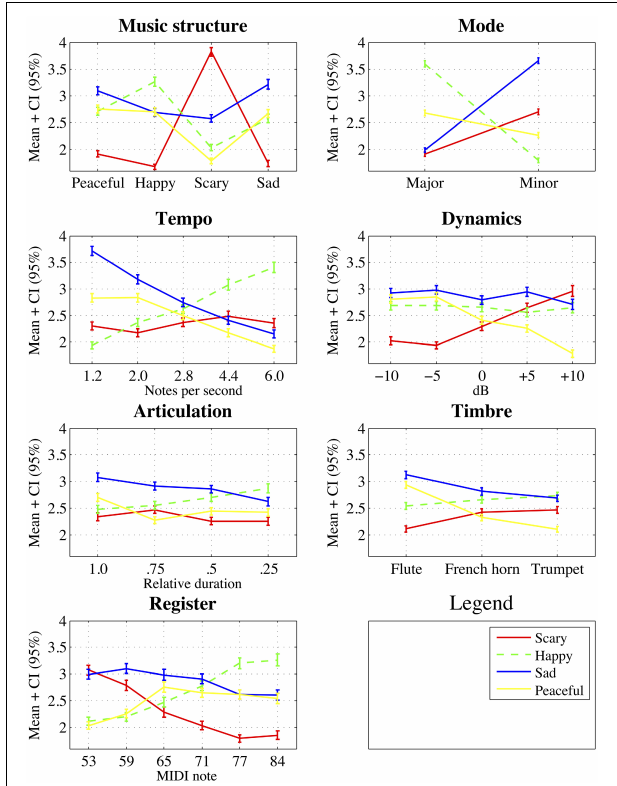
FIGURE 2 | Means and 95% confidence intervals of four emotion ratings across all musical cues and levels.